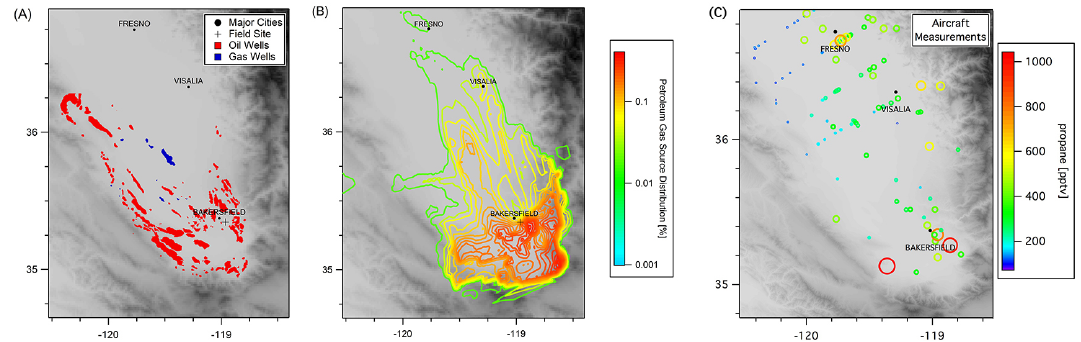
Figure 10. Maps of the southern part of the San Joaquin Valley with (A) the location of oil and gas wells, (B) the spatial distribution of petroleum gas emissions determined using statistical footprint analysis (6h), and (C) aircraft canister measurements of propane, sized and colored by concentration. Together the maps show a similar distribution of wells and emissions in the region. Note: meteorological conditions, altitude, and local dilution varies between canister measurements. Table 7. Comparison of the relative abundance of VOC emissions from each source observed in Bakersfield to CARB inventory for the San Joaquin Valley (SJV) and the portion of Kern County in the San Joaquin Valley including Bakersfield (SJV-Kern). Relative mass Fraction of emissions [%] in in- abundance in ventory (absolute emission Bakersfield rate [tons day − 1 ]) (this study) SJV inventory SJV-Kern inventory Petroleum operations 22% 15% (28) 53% (26) Dairy operations 22% 30% (57) 9% (4.5) On- & off-road motor 56% 55% (104) 38% vehicles